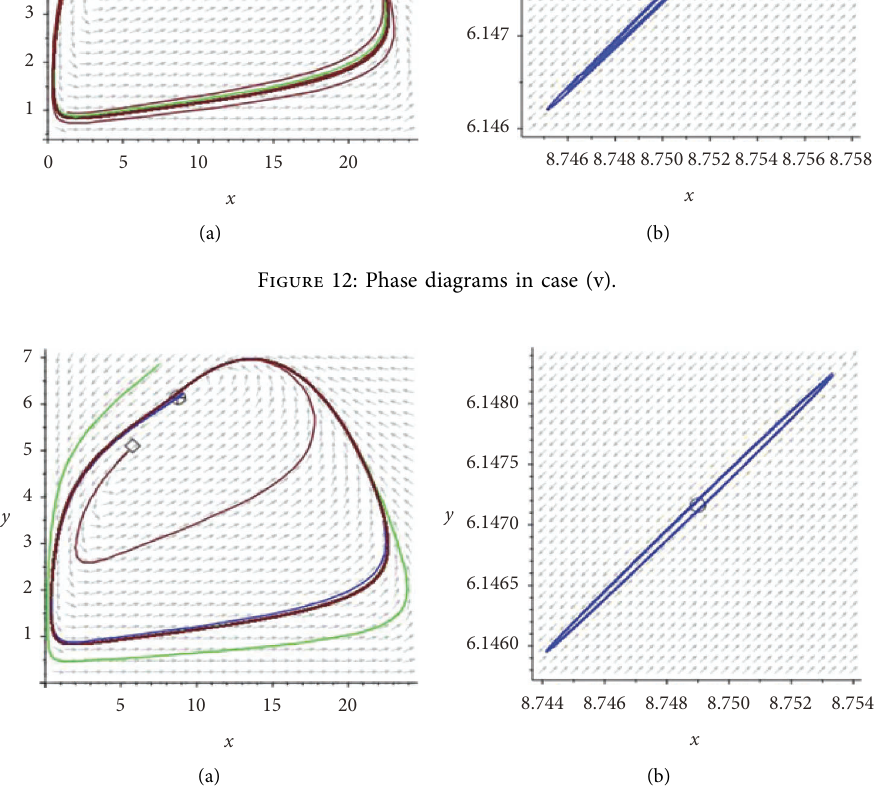
Figure 13: Phase diagrams in case